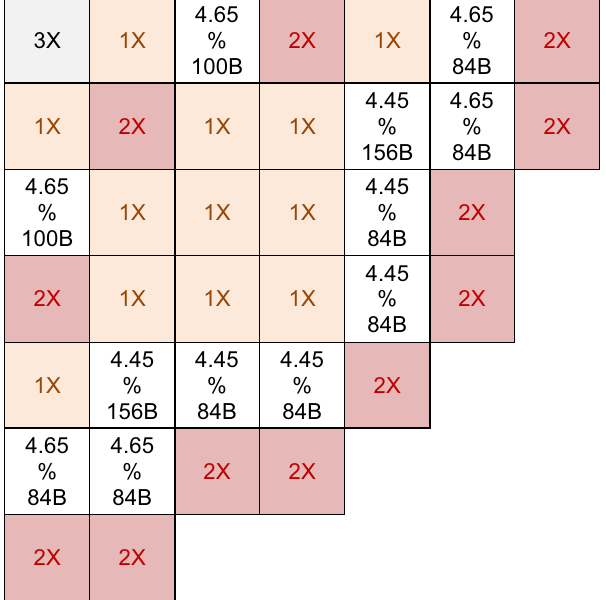
Fig. 1. I 2 S-LWR equilibrium cycle core loading pattern (bottom right quadrant of the